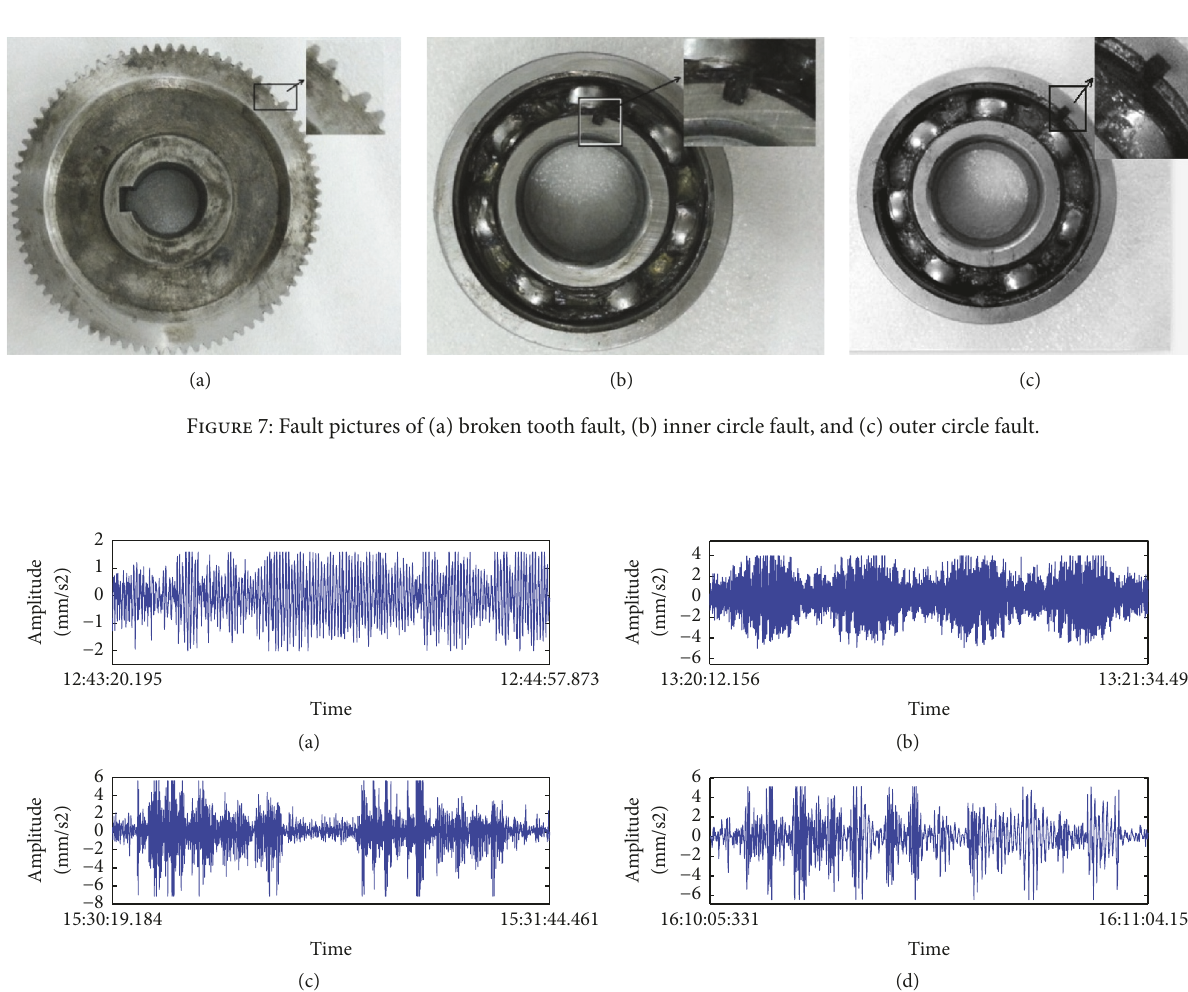
Figure 8: Original waveforms of various states of the gearbox: (a) vibration signal of normal state, (b) vibration signal of broken tooth fault, (c) vibration signal of 4# bearing inner circle fault, (d) vibration signal of 4# bearing outer circle